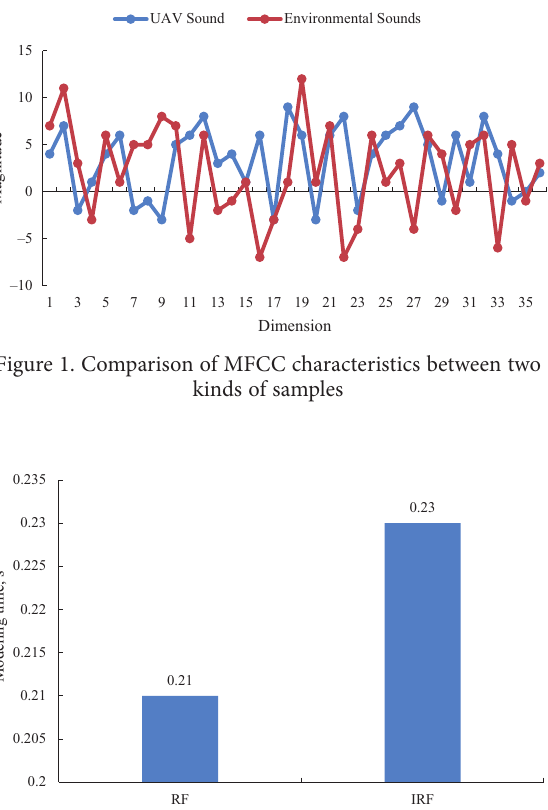
Figure 4. Comparison of ambient sound recognition rates at different